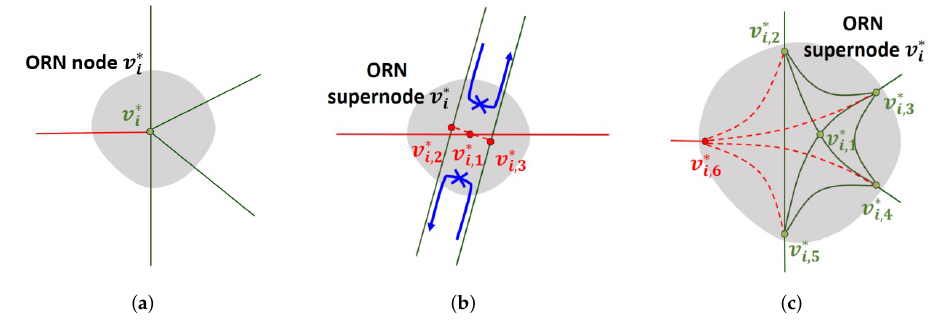
Figure 12. Addition of ORN subgraph to the existing ORN (super)node v ∗ ( b ) dual carriage road, and ( c ) complex intersection.